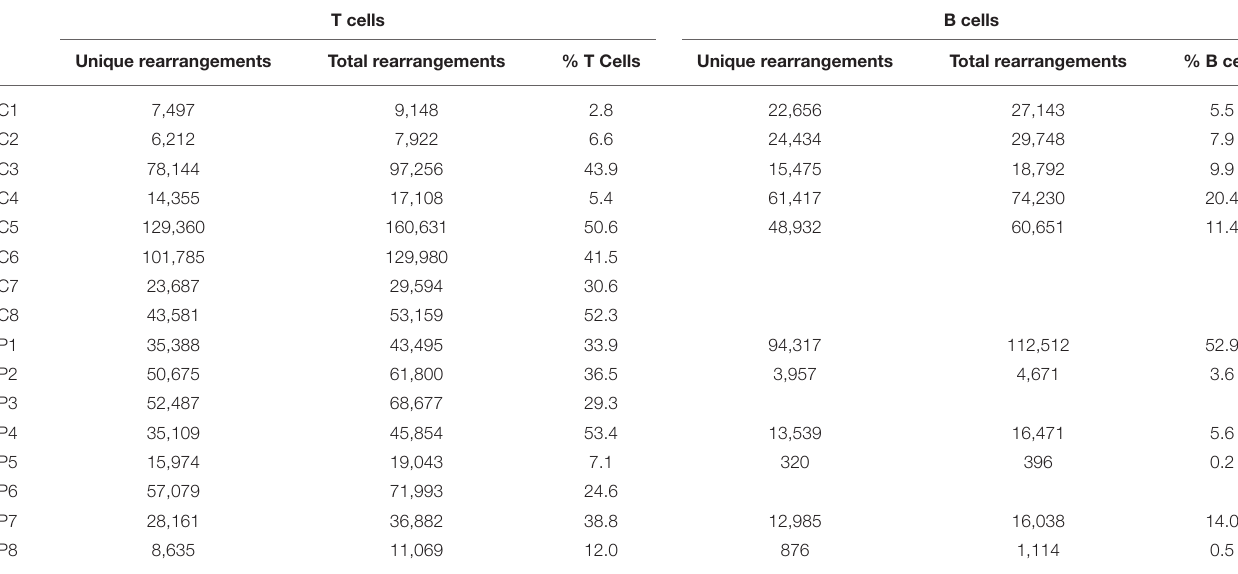
TABLE 3 | Sample overview of participating subjects. T cells B